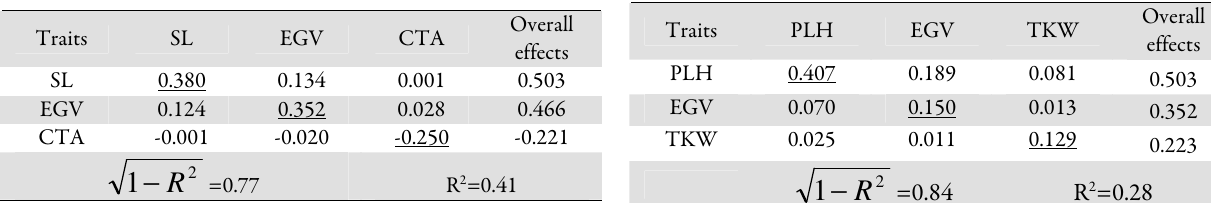
Tab. 5. Direct and indirect effects of second order predictor variables on grain yield by plant height as response variable